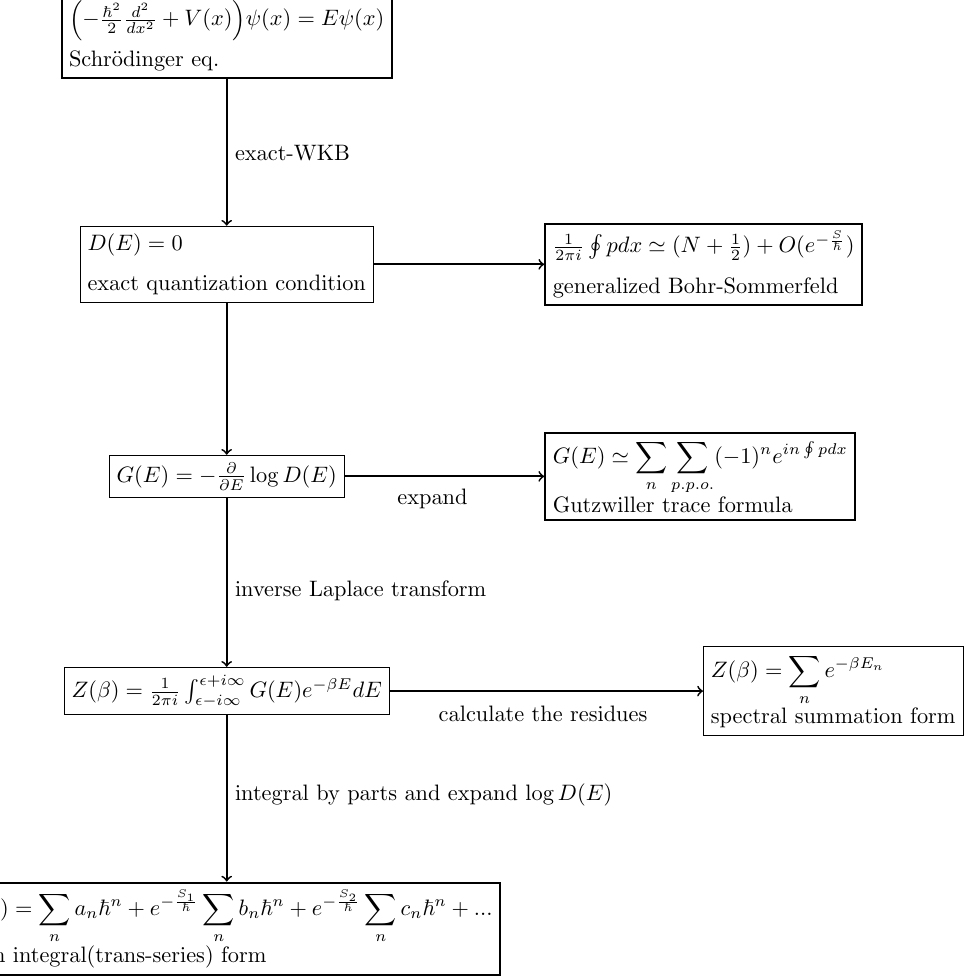
Figure 1 . The relation among several quantization methods( Z N -shift symmetry given by x → FIG. 1. The relation among several quantization methods. We can identify the resurgent structure of each x + 2 pπ/N .). We can identify the resurgent structure of each case without approximation from the case without approximation from the exact-WKB.